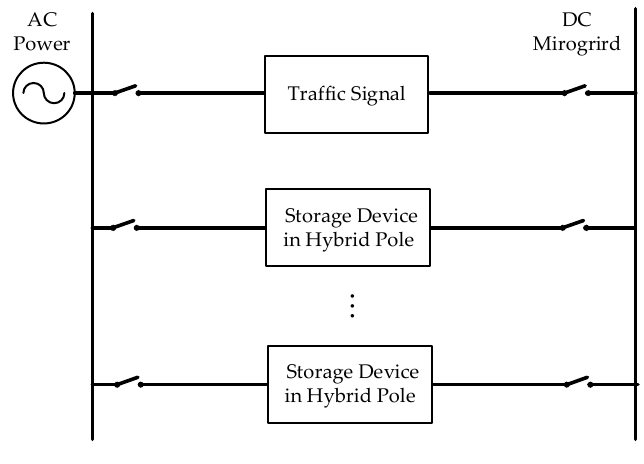
Figure 5. The backup power for traffic signal.